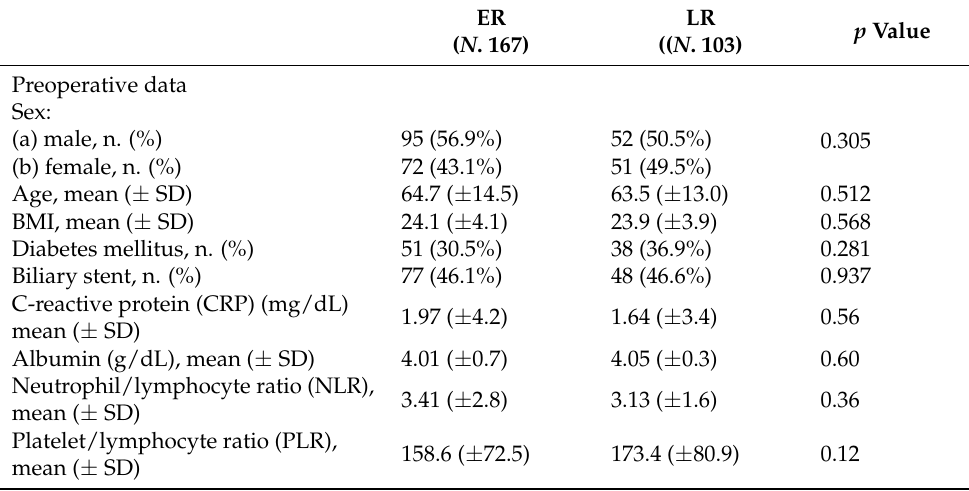
Table 3. Demographic, clinical, and pathological data of patients with ER and LR.